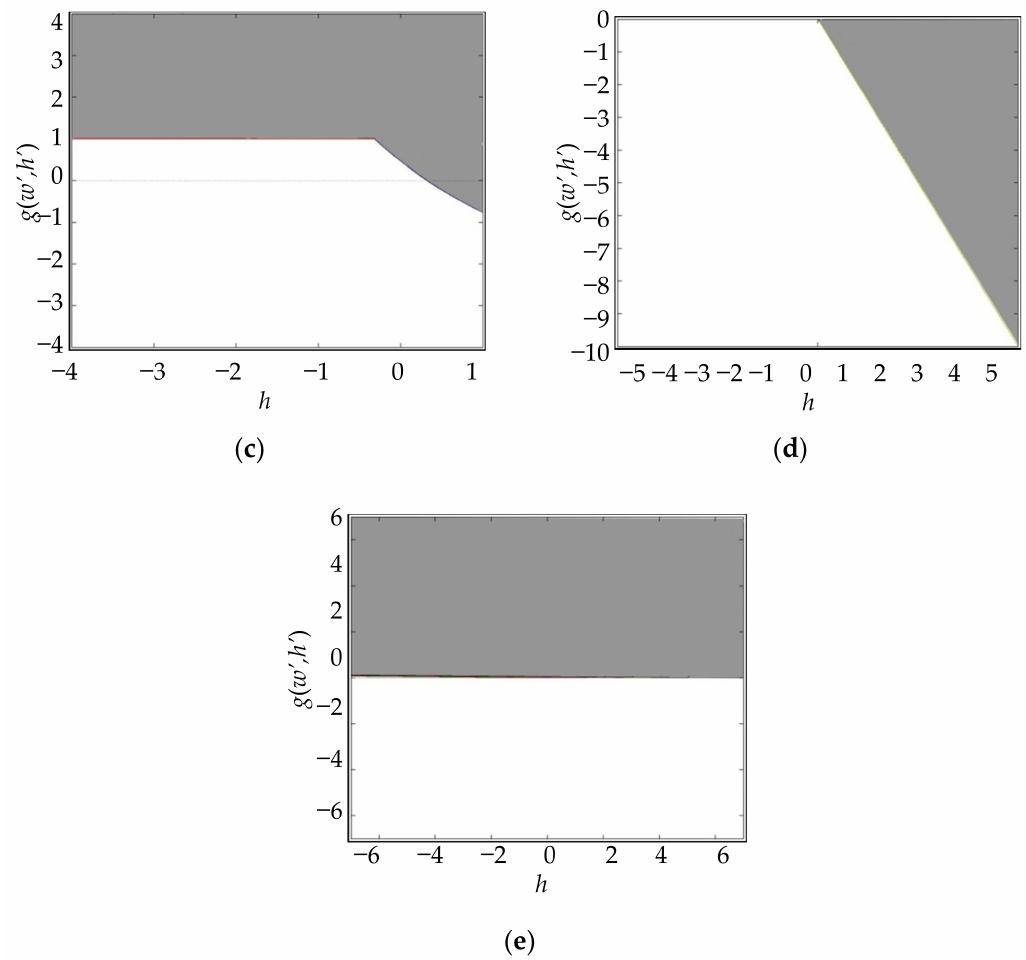
Figure 5. The gray part is the coverage area of g ( w (cid:48) , h (cid:48) ): ( a ) The grey area covered by the g ( w (cid:48) , h (cid:48) ) function when σ = sigmoid and y label > 1. If h (cid:48) ≤ 0.5, g ( w (cid:48) , h (cid:48) ) is always positive; ( b ) The grey area covered by the g ( w (cid:48) , h (cid:48) ) function when σ = tanh, y label > 3, and w ≤ 0. If h (cid:48) ≤ 0.3, g ( w (cid:48) , h (cid:48) ) is always positive; ( c ) The grey area covered by the g ( w (cid:48) , h (cid:48) ) function when σ = tanh, y